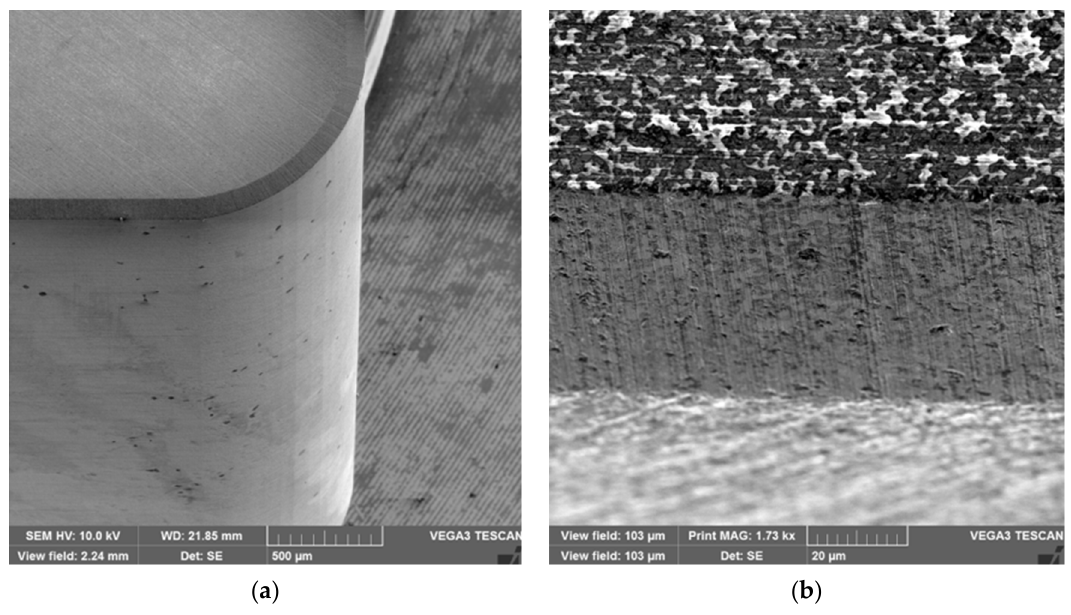
Figure 2. SEM images of the general view ( a ) and the cutting part ( b ) of commercially available CC650 ceramic inserts used in testing.